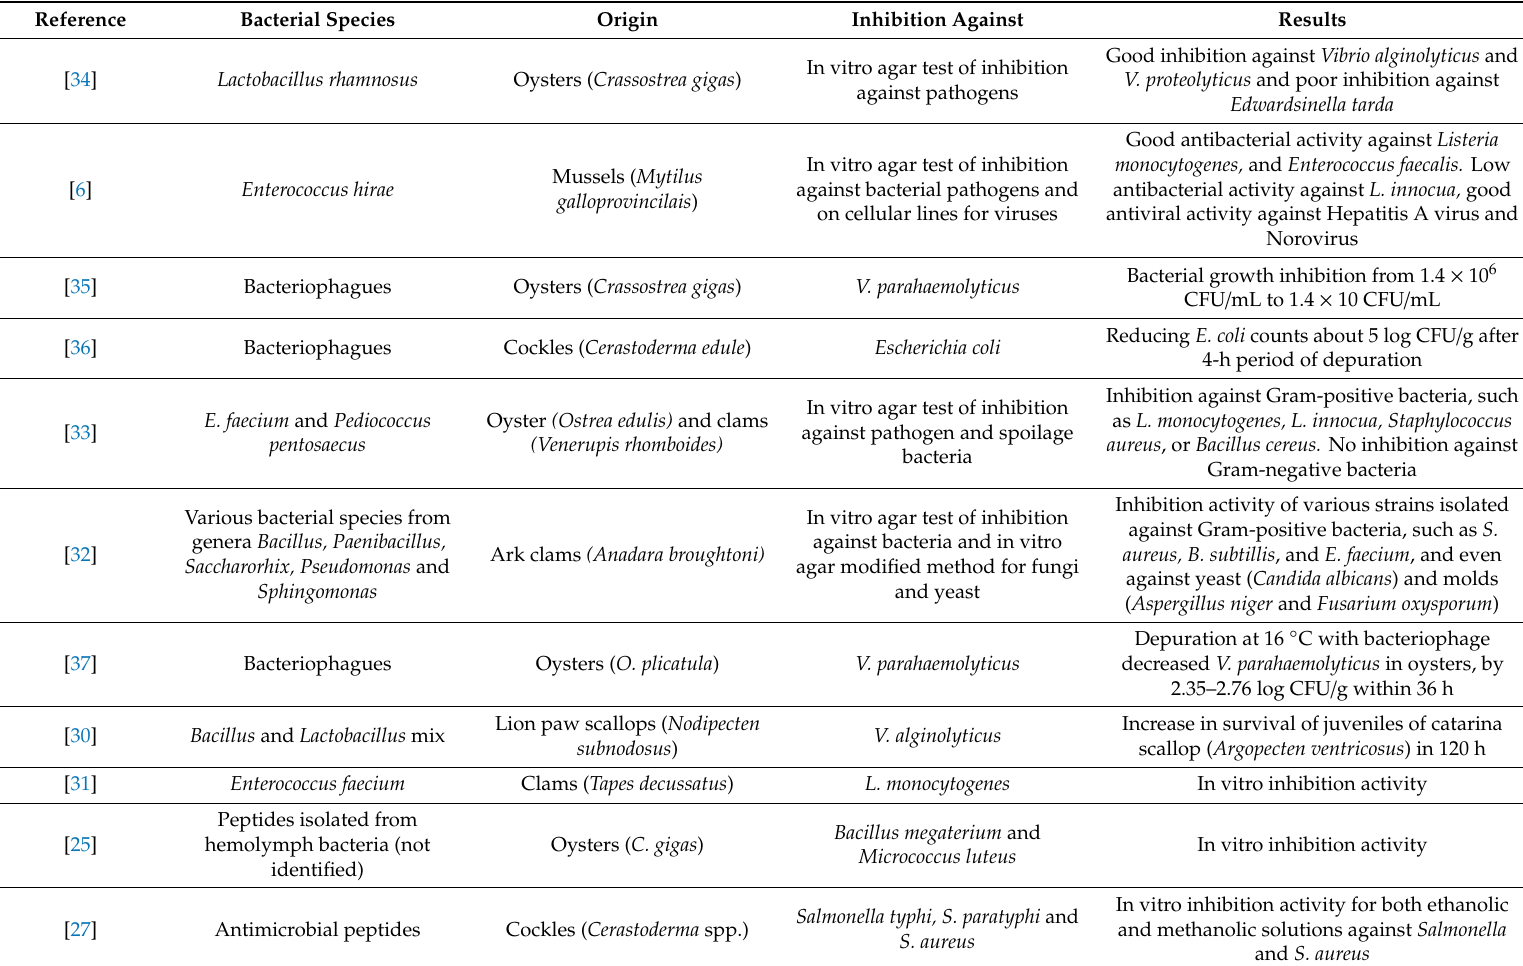
Table 2. Bacterial species producing bacteriocins isolated from